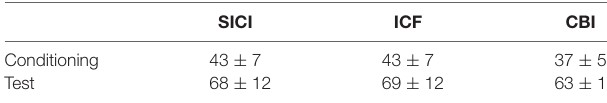
TABLE 1 | The transcranial magnetic stimulation (TMS) intensity ∗ adopted for measuring short-interval intracortical inhibition (SICI), intracortical facilitation (ICF) and cerebello-motor cortical inhibition (CBI). SICI